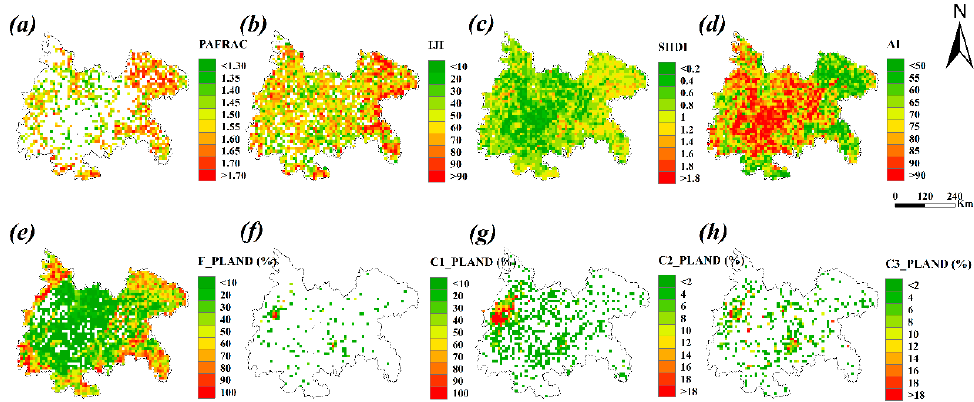
Figure 7. Landscape patterns of ( a ) PAFRAC; ( b ) IJI; ( c ) SHDI; ( d ) AI; ( e ) F_PLAND; ( f ) C1_PLAND; ( g ) C2_PLAND; and ( h ) C3_PLAND in the Chengdu-Chongqing urban agglomeration.